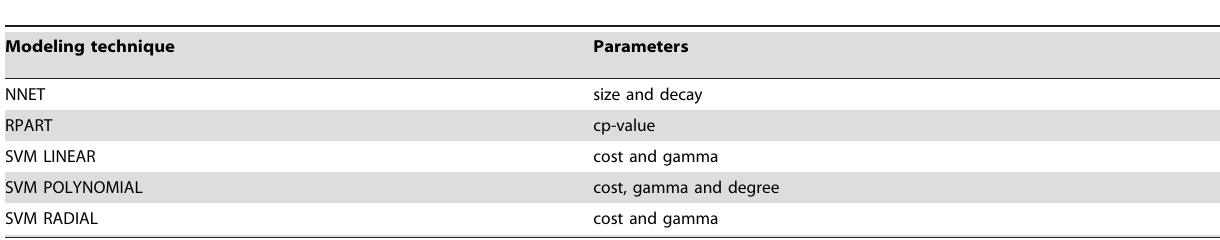
Table 1. Parameters required for the modeling techniques.